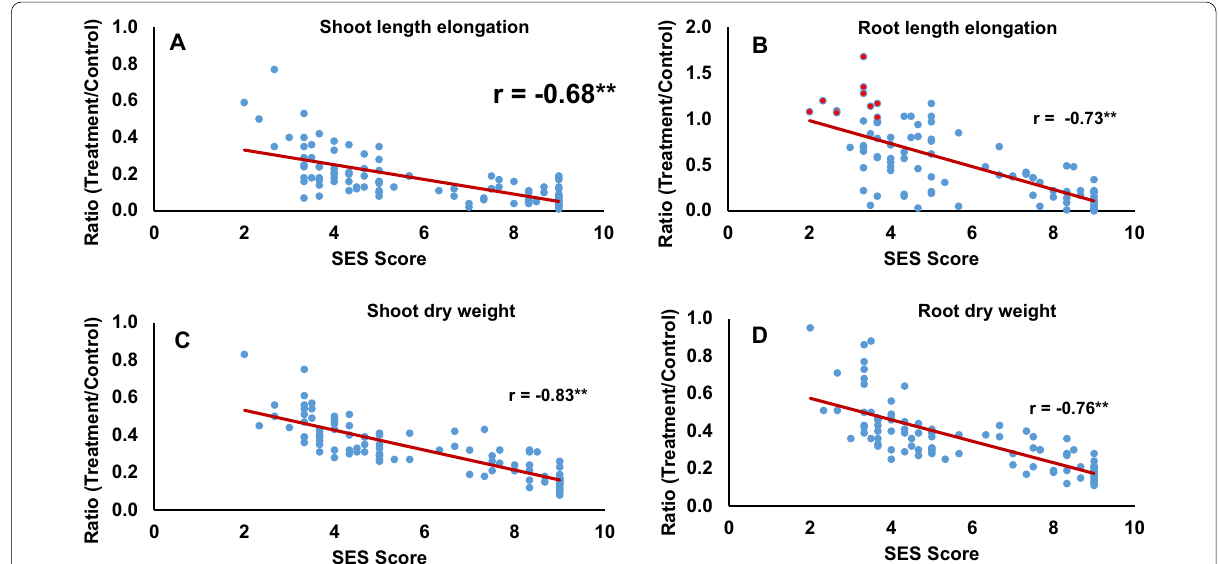
Fig. 2 Correlations between four phenotypic traits and SES scores across the 97 accessions at 20 DUT with 100 mM NaCl. A Shoot length elongation ratio. B Root length elongation ratio. C Shoot dry weight ratio. D Root dry weight ratio. All correlations were significant ( p value